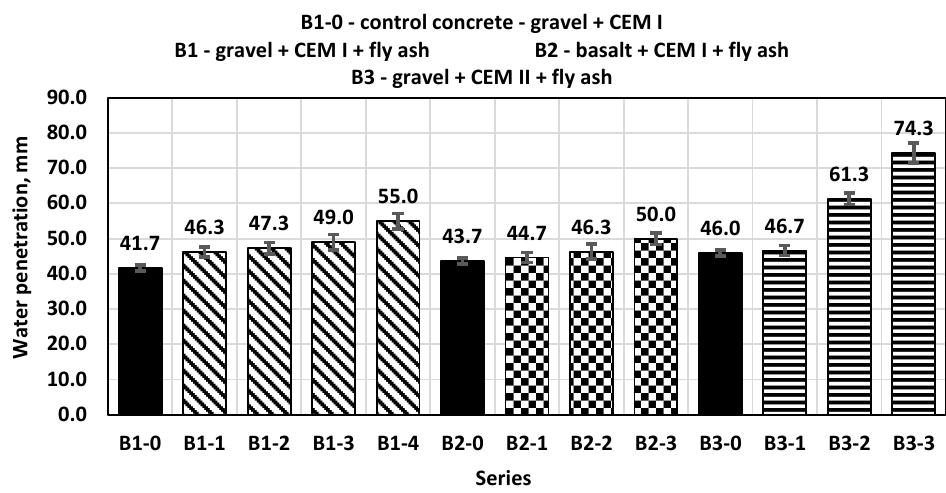
Figure 8. Water penetration of control concretes and concretes with the addition of fly ash.